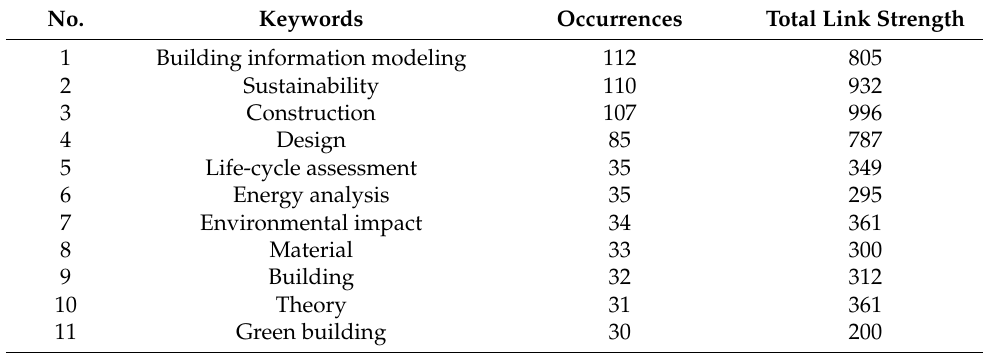
Table 10. Keyword occurrences and total link strength.